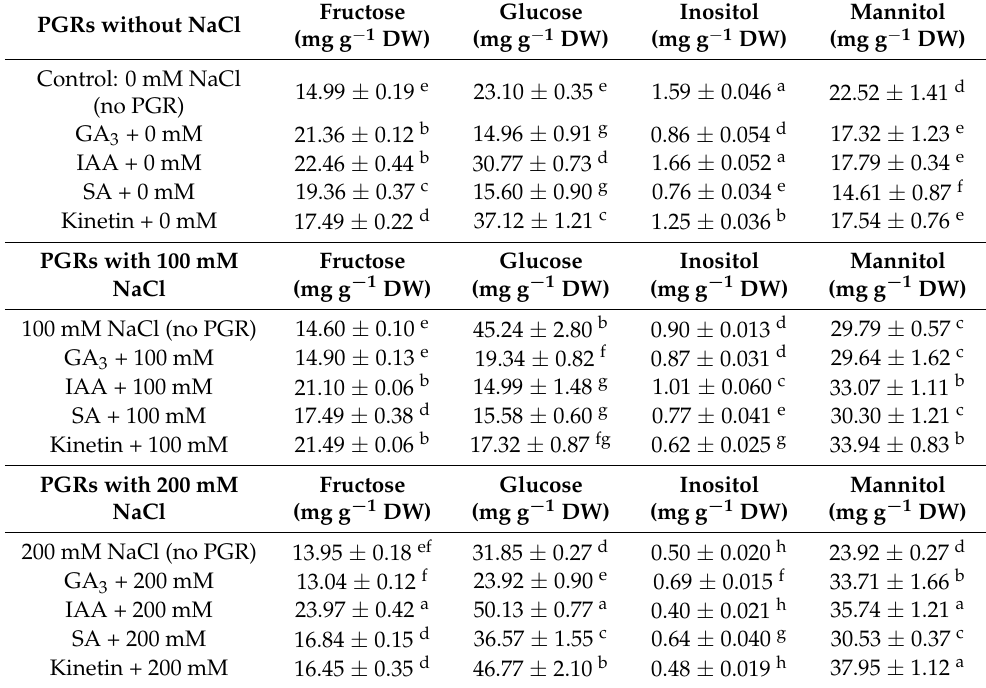
Table 5. Effect of salt stress on fructose, glucose, inositol, and mannitol concentrations in leaf Olea europaea plants pretreated with plant growth regulators (PGRs). Data are expressed as mean ± SE (n = 4).